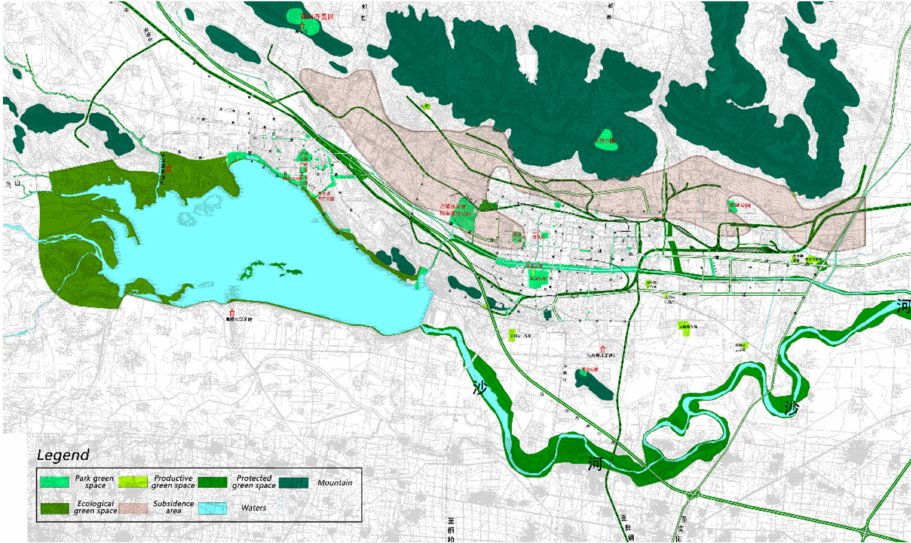
Figure 9. Ecological status map of the Northern mining area.